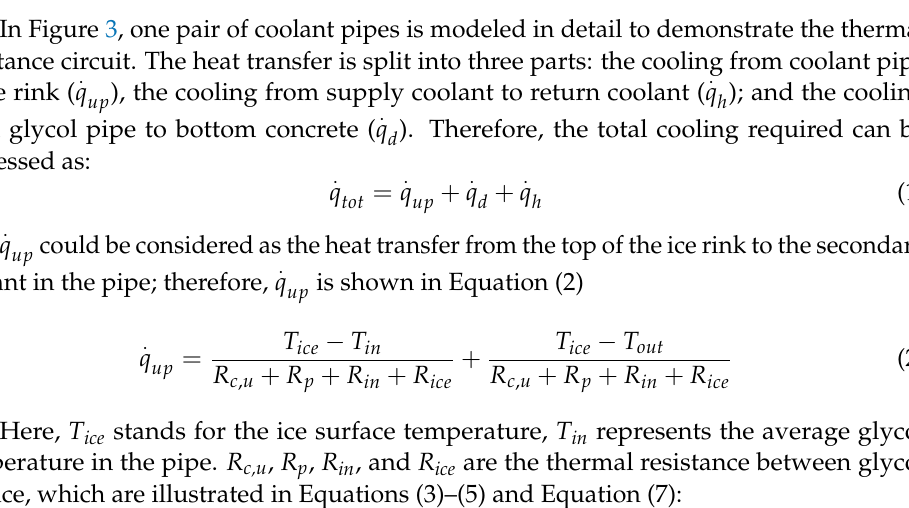
Figure 3. Discrete heat transfer model for embedded rink